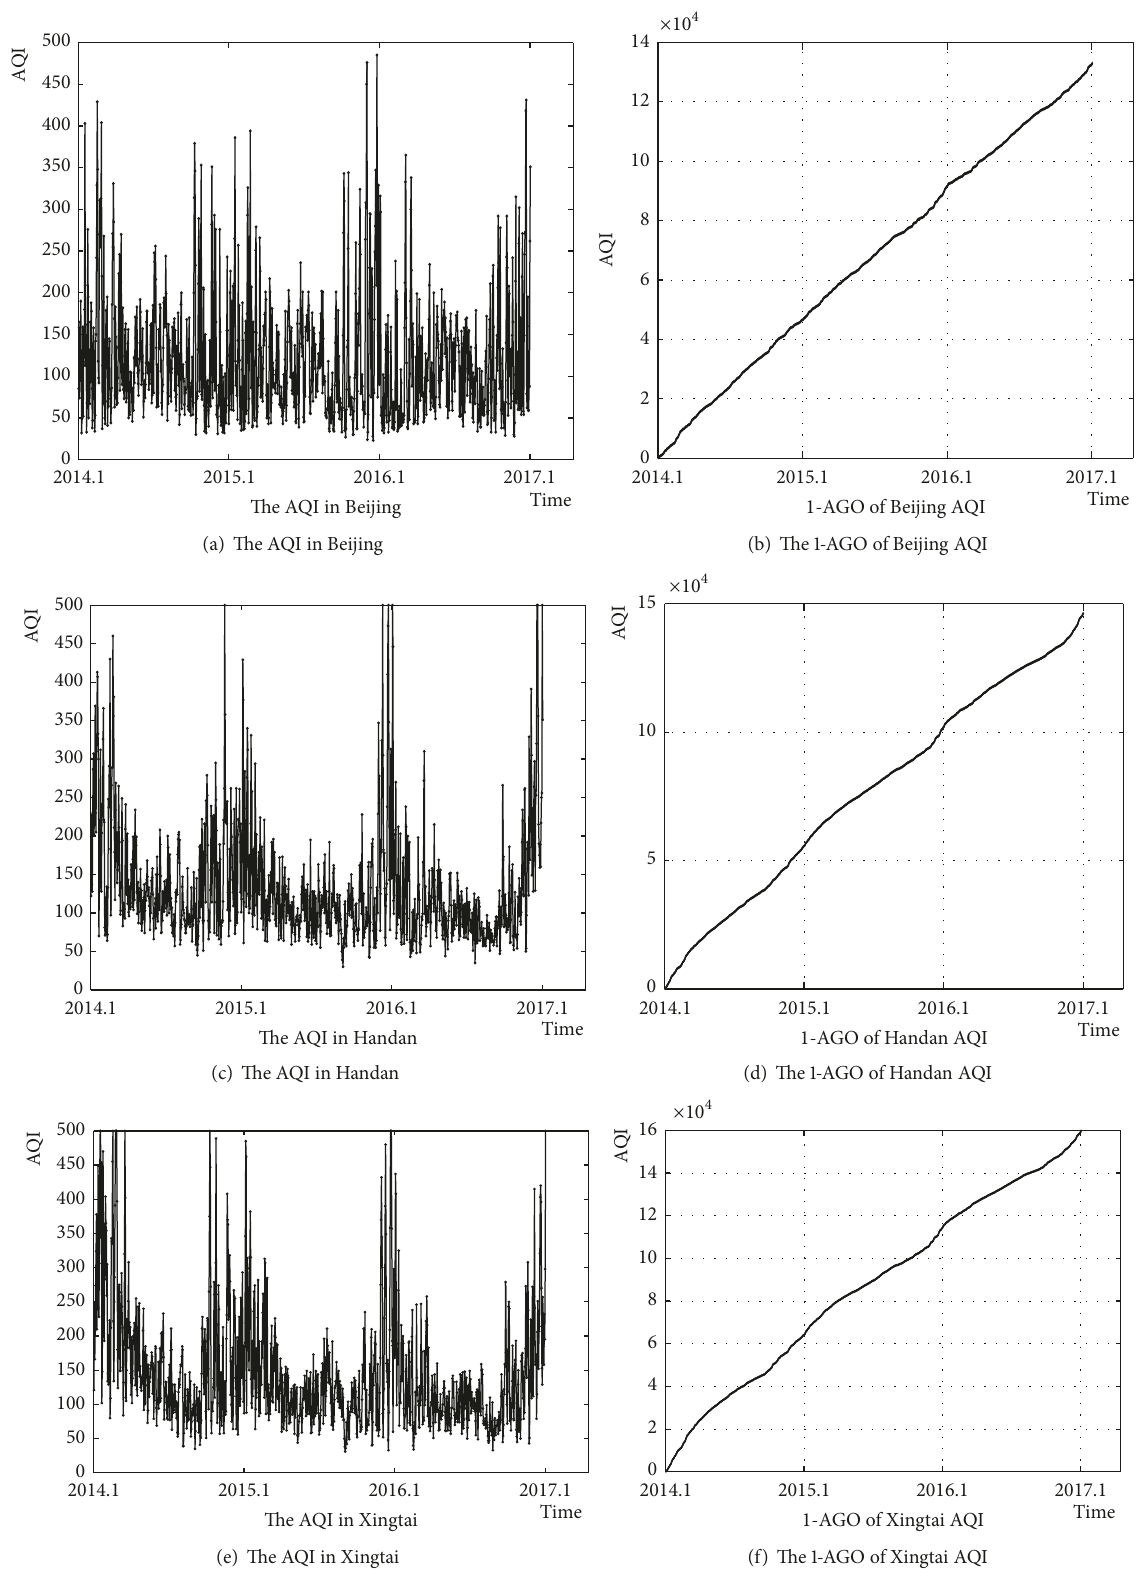
Figure 3: The original AQI value and one-order accumulation value of three